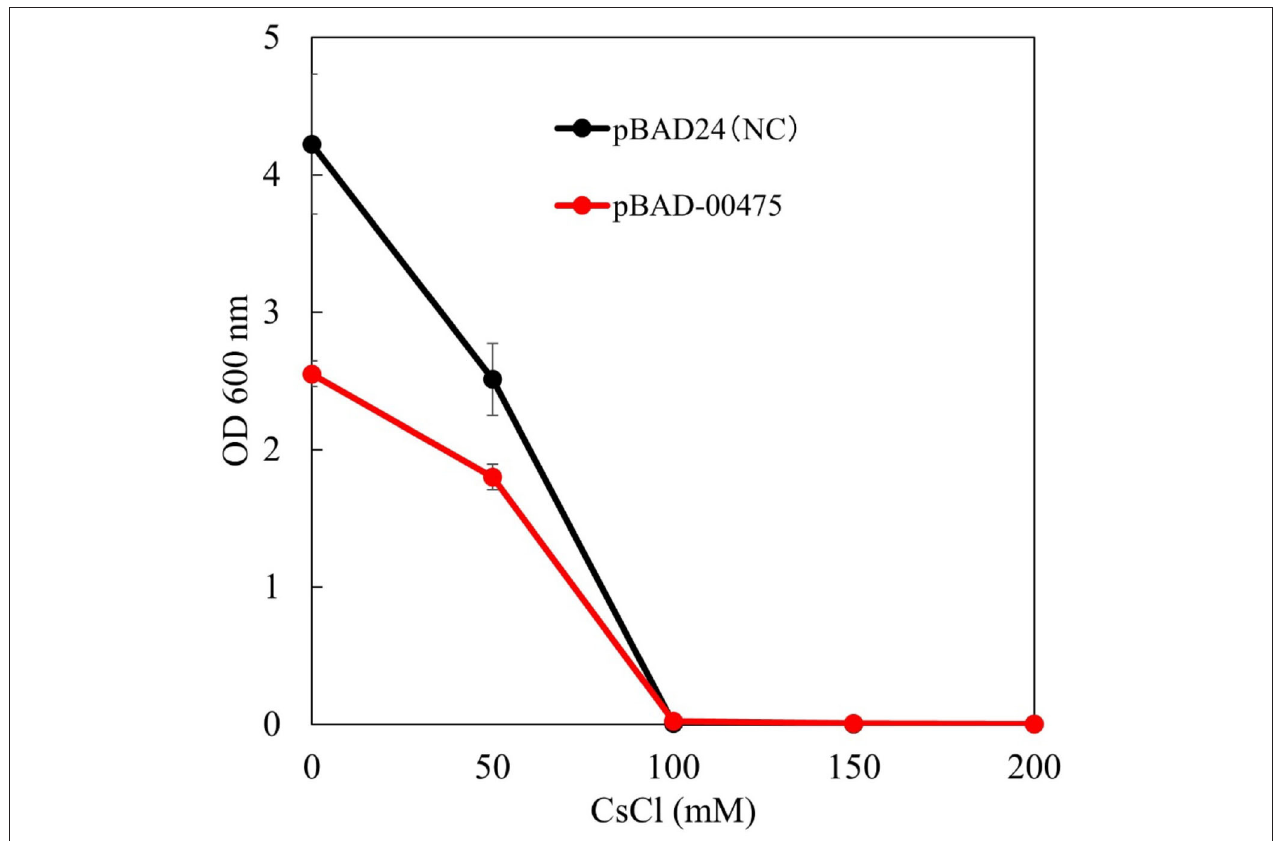
FIGURE 8 | Test to evaluate the Cs + resistance growth of strain KNabc/pBAD-00475. The turbidity of each concentration of CsCl when strain KNabc/pBAD-00475 in LBK medium was cultured for 16h. Error bars show the standard deviation of three independent experiments. As the negative control, KNabc/pBAD24 was used.